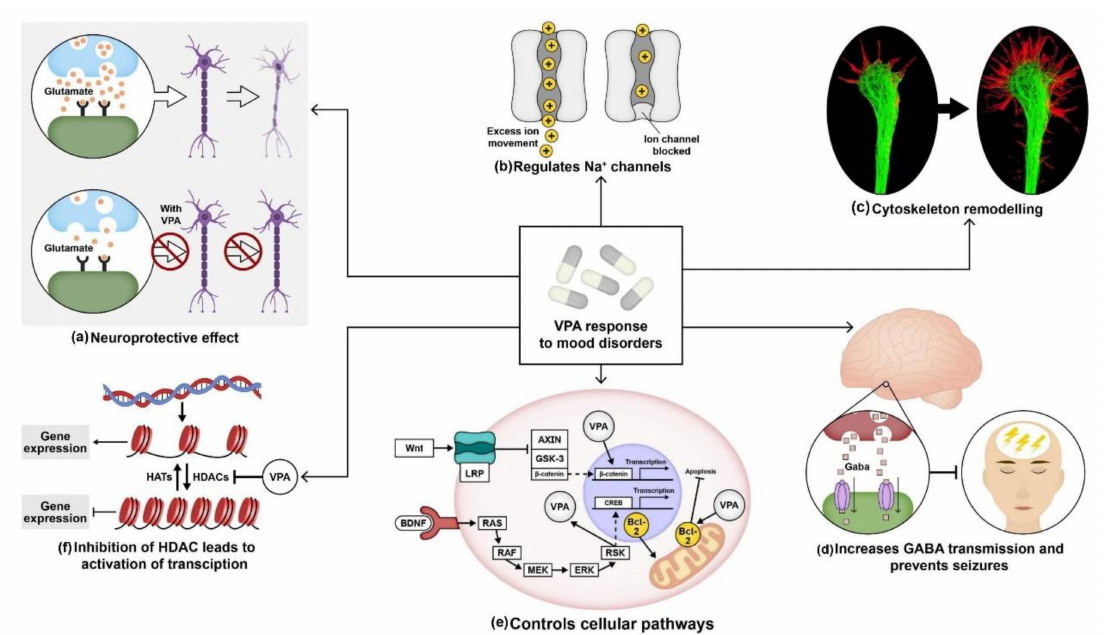
Figure 2. Molecular and therapeutical potential of valproic acid (VPA): ( a ) VPA protects neurons from glutamate-induced excitotoxicity; ( b ) it regulates sodium channels by delaying the activation of voltage-dependent sodium channels; ( c ) like lithium, VPA also helps in cytoskeleton remodeling; ( d ) administration of VPA increases GABA levels and prevents seizures. ( e ) It activates wnt and mitogen-activated protein kinase (MAPK) pathway by blocking constitutively activated glycogen synthase kinase-3 (GSk-3). Furthermore, it also enhances BCl-2 levels that hinder mitochondrial dysfunction. ( f ) VPA also controls the transcription mechanism by inhibiting HDAC